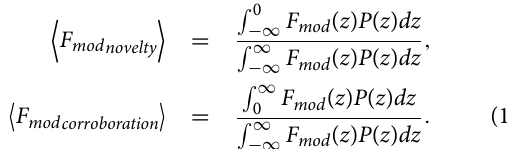
found. Right : Color coded relaxation times after changes in the set of moral issues. Note that at the transition relaxation times are very large. This is called critical slowing down. For the agents identified with respondents of the MFTQ, the lowest times correspond to those liberal identified agents and the largest times to conservative identified agents. The line just above the transition shows the locus of minimum correlation time as a function of β , for fixed ρ